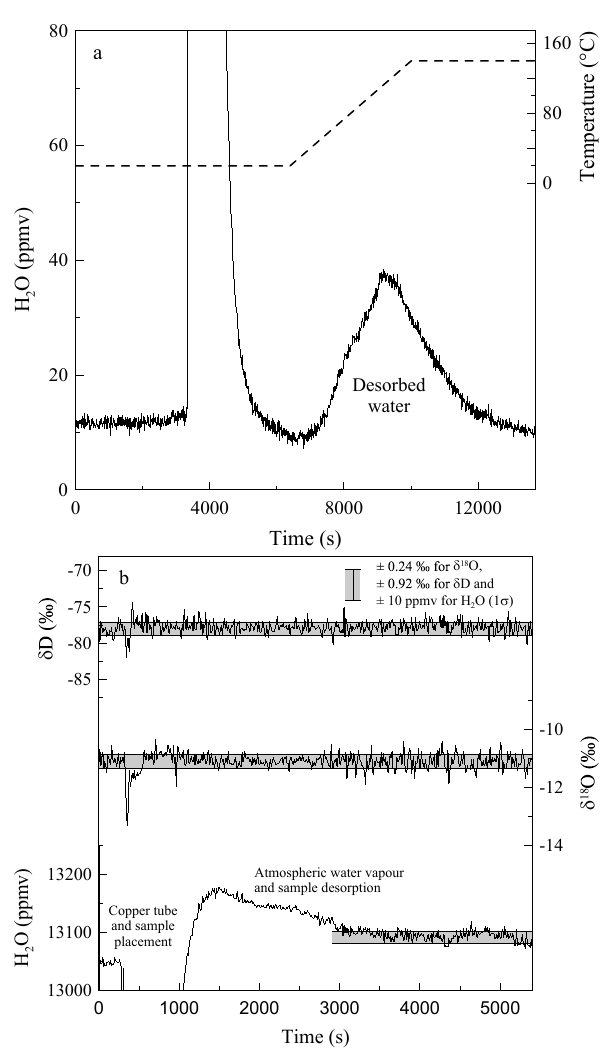
Figure 3. (a) Desorption test: The large peak corresponds to am- bient water vapour migration during the opening of the line when loading the sample. After closing, the sample is flushed with a dry nitrogen stream without heating. After reaching the dry background level the system is heated to 140 ◦ C to desorb the water from the calcite. (b) Example of desorption and stabilisation of water vapour amount and its isotopic composition after loading the sample. Des- orption from the sample surface or from fluid inclusion cracks is hardly visible at this